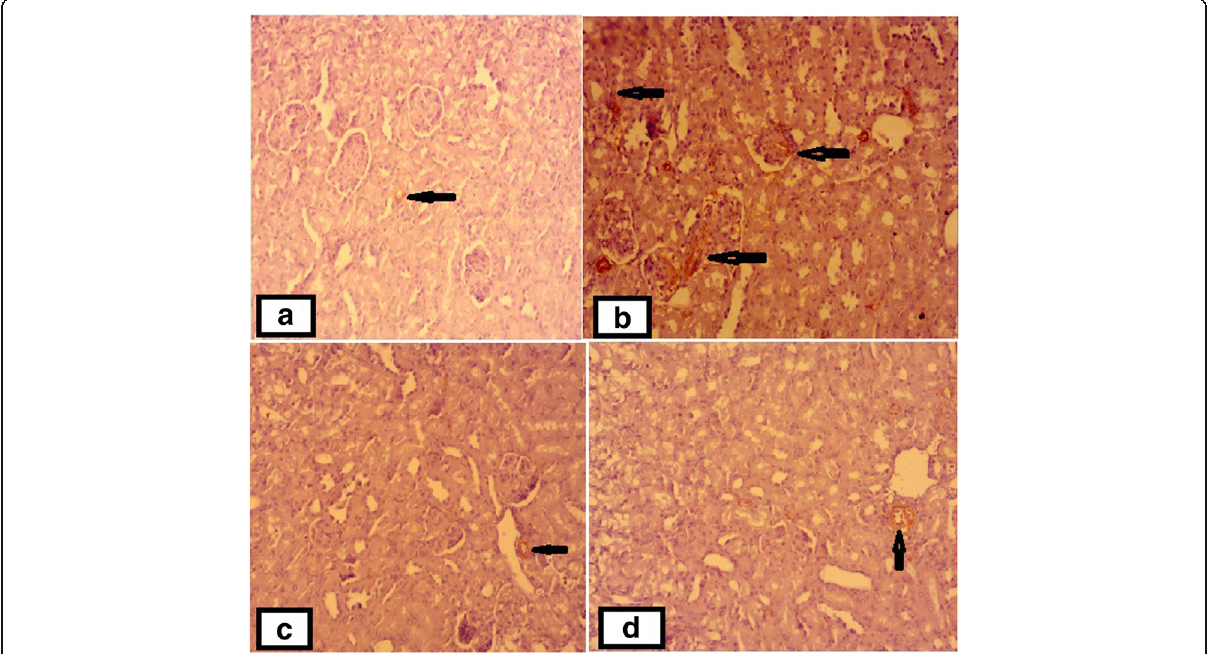
Fig. 8 Photomicrographs of immunohistochemistry expression of Ang II from the kidney tissues (×10). Low level of Ang II observed in the control group mainly in the tubular cells (arrow) ( a ). Ang II expression was elevated in glomerulus, tubular cells, interstitial cells, and blood vessels (arrows) in group II ( b ). c , d For GIII and GIV respectively revealed normal Ang II content in renal